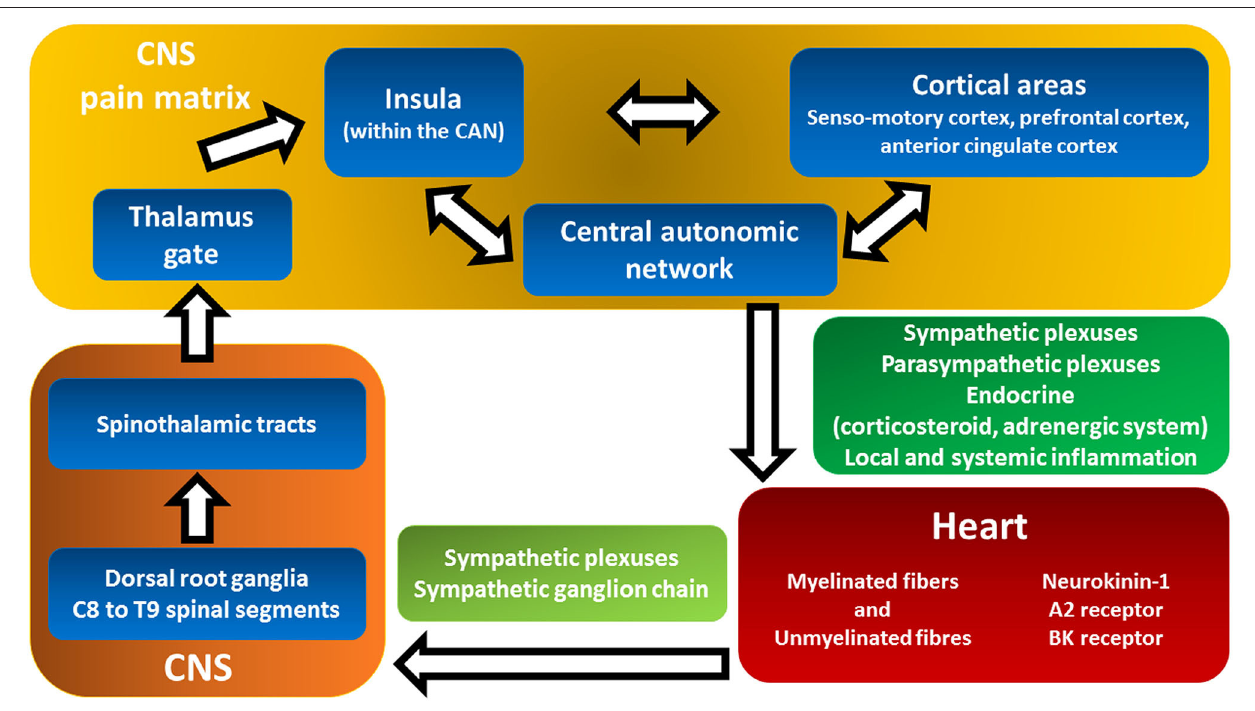
FIGURE 3 | Cardiac pain transmission and modulation pathways from the heart to pain matrix in the central nervous system. This figure shows the complex and multilevel genesis and processing of cardiac pain and the associated symptoms triggered by ischemia. Myocardial-visceral pain perception (red box) is transmitted to and modulated by the pain matrix (yellow box) in an extremely broad range of conscious pain sensations that convoy a large spectrum of subject’s negative experiences: dyspnea, fatigue, dyspepsia, fear, and sense of imminent death (see text for details). Backwards, the central autonomic network in the CNS exerts both local and systemic effects on the inotropic and chronotropic activity of the heart as well as coronary macro- and microcirculation (green box, see Figure 2 for details). A2 receptors, adenosine 2 receptors; BK, bradykinin; CAN, central autonomic network; CNS, central nervous